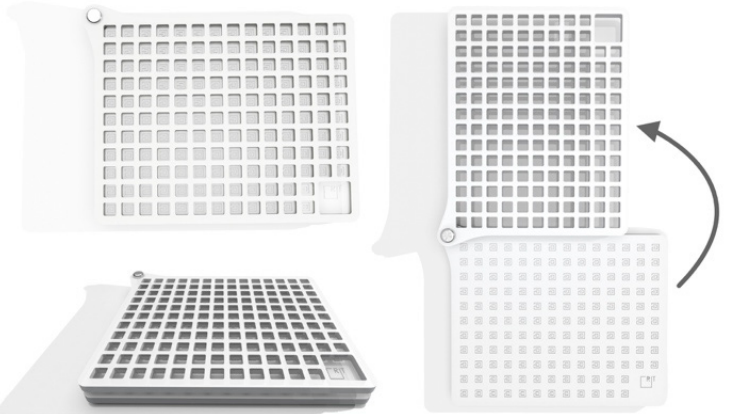
Figure 1. Design of the microfluidic trainer (MT). The closed MT device (left panel). The opened MT device (right panel).